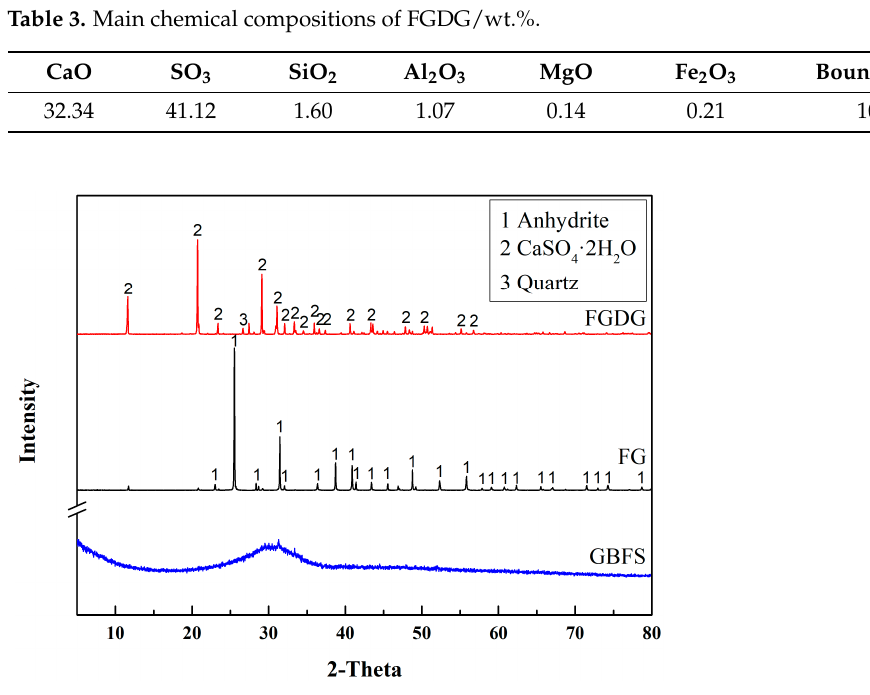
Figure 1. XRD pattern of mineral composition of GBFS, FG and FGDG.